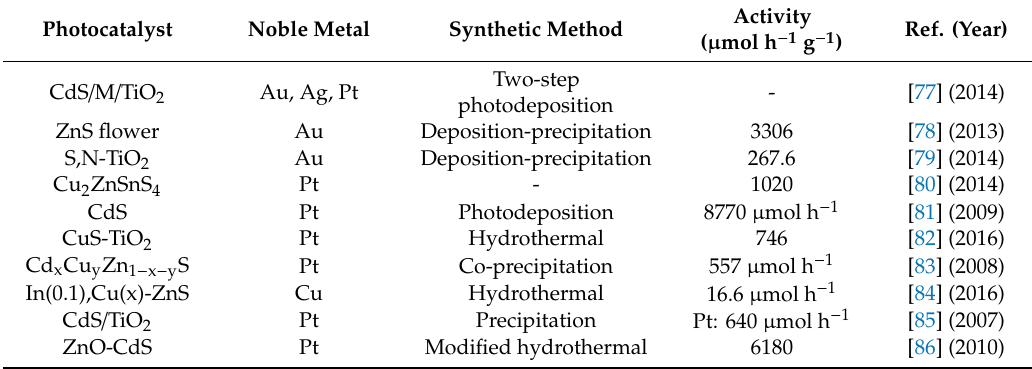
Table 7. Photocatalytic H 2 generation for noble metal-loaded